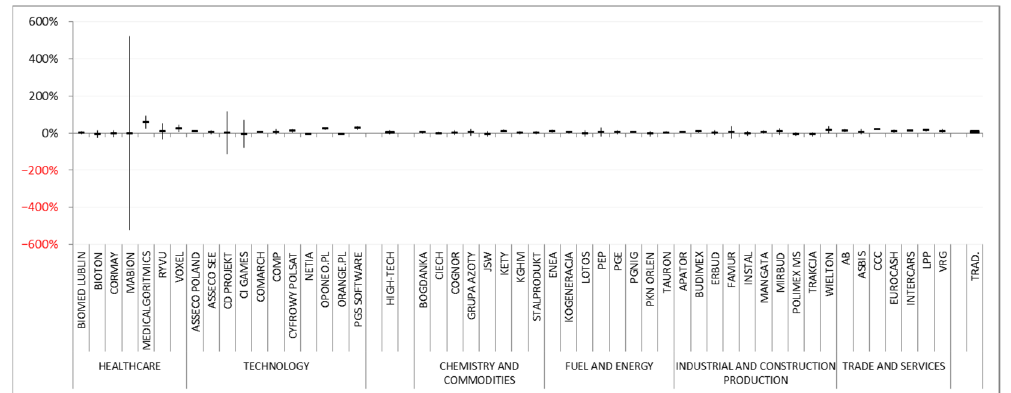
Figure 5. A typical area of variation of sales revenues in the surveyed enterprises. Source: own work.